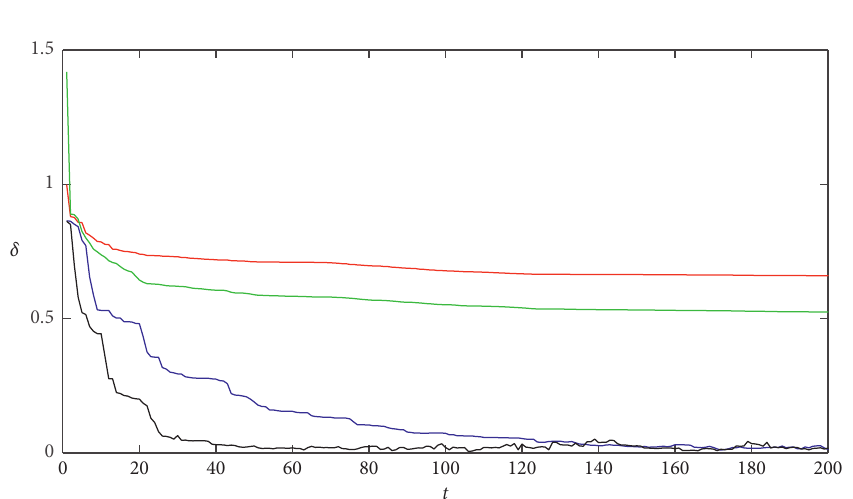
Figure 1: The simulation data.